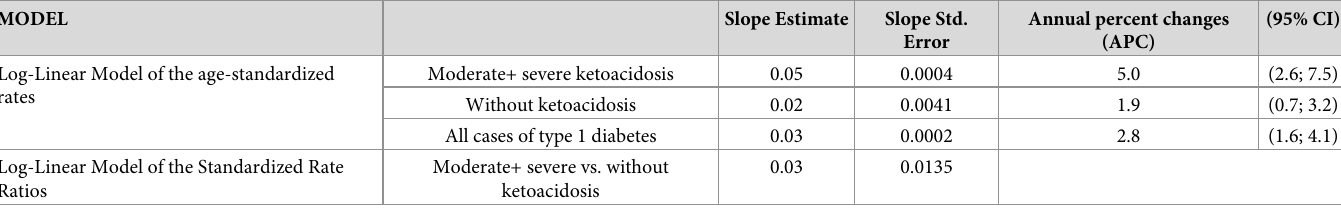
Table 3. Results of the trend analyses in relation to ketoacidosis using join point regression.